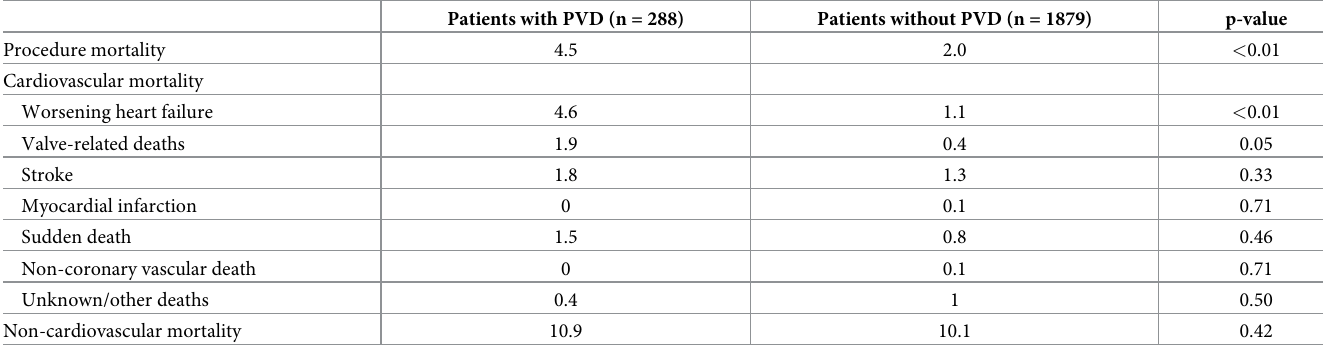
Table 5. Comparison of causes of death between patients with and without PVD. Patients with PVD (n = 288) Patients without PVD (n =